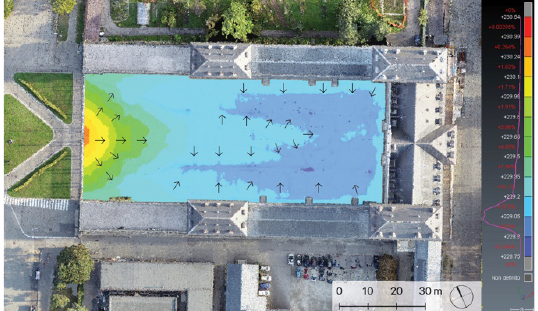
Figure 15. Analyses on the slope of the courtyard ‘s surface.